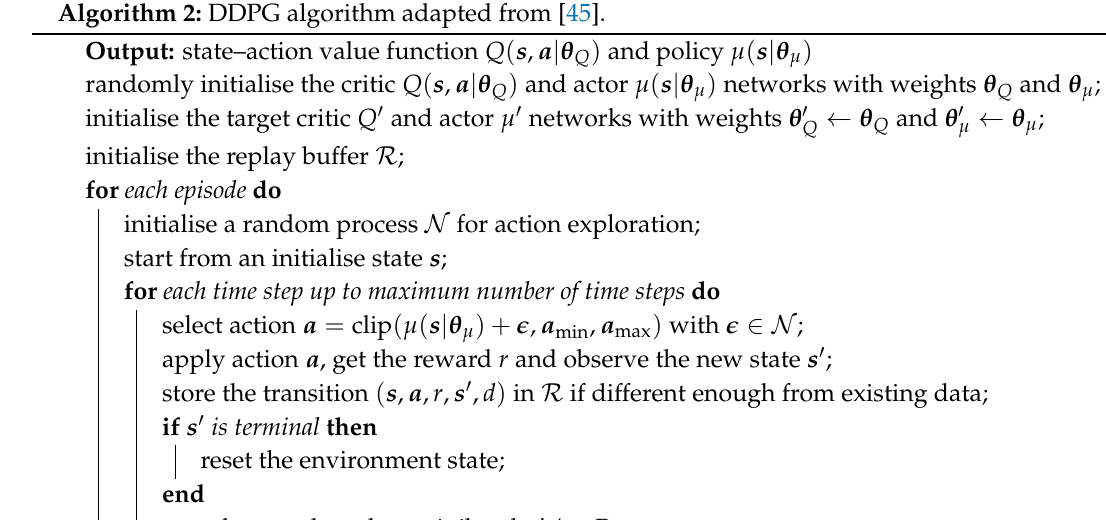
Algorithm 2: DDPG algorithm adapted from